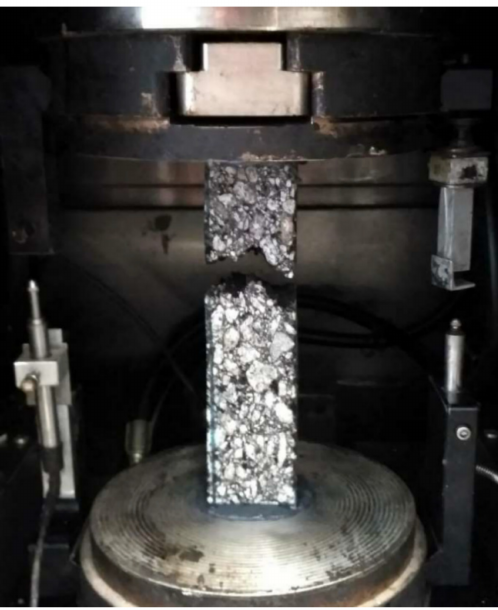
Figure 7. Example of tested specimen in the UTST test. Table 6. Tensile strength results, β t, from UTST for SMA 11 mixtures with PMB25 and PMB50.